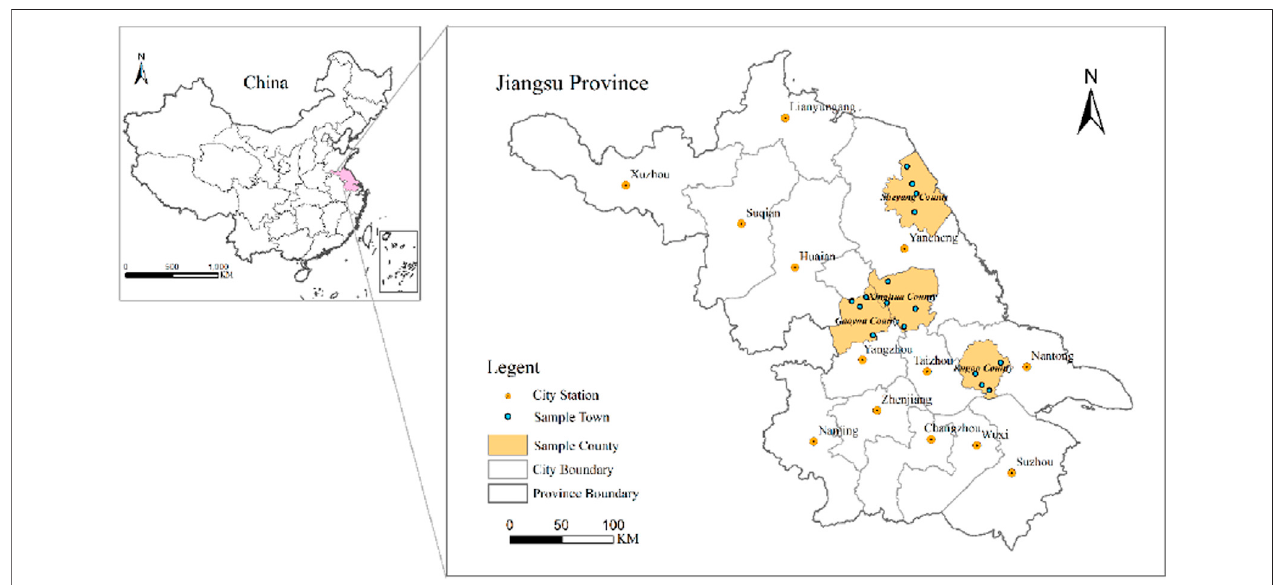
FIGURE 1 | Location of jiangsu province in China and the study